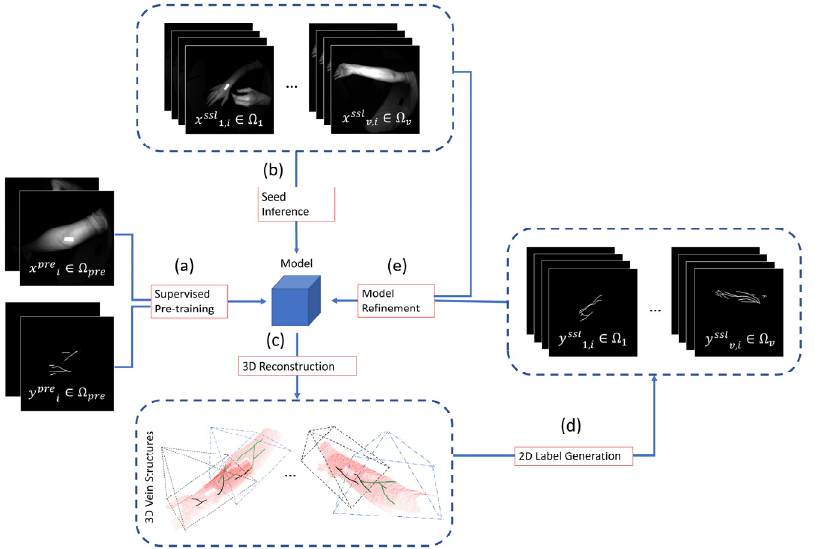
Figure 5. Overview of Semi-supervised Learning pipeline: ( a ) Model initialized and trained on small dataset with noisy labels; ( b ) Unlabeled videos are collected and passed through the pre-trained model to produce a seed inference; ( c ) Model per-image outputs are pooled on a per-video basis as a 3D point cloud; ( d , e ) New segmentation labels are generated and used to fine-tune the model. Steps ( c – e ) are repeated for several iterations (super-epochs), with more videos being included into the training and validation sets per loop iteration.